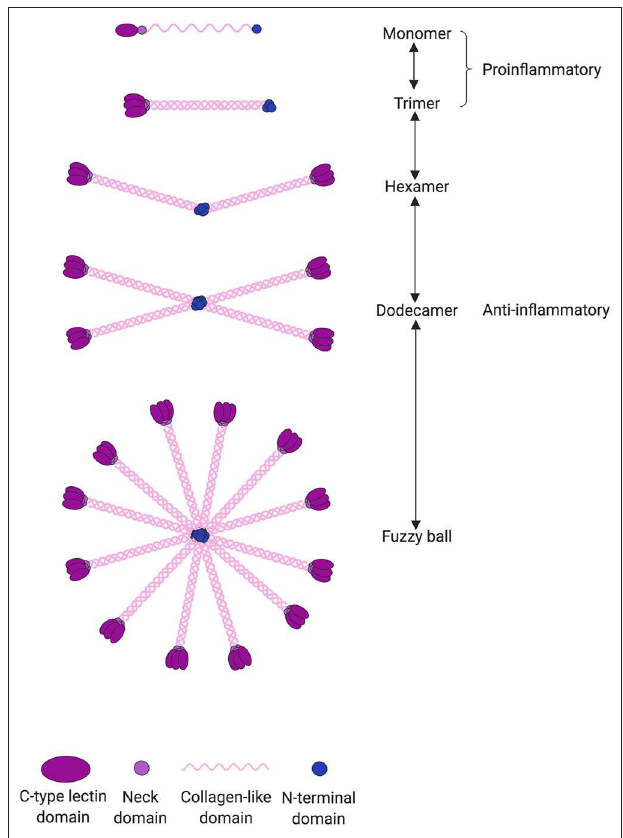
FIGURE 1 | SP-D can undergo several post-translational modifications leading to changes in both structure and function. SP-D is capable of multimerization depending on the local environment. The most common isoform is the dodecameric structure, which is thought to have anti-inflammatory properties through binding via its C-type lectin domain. However, in an inflammatory or more acidic environment, the dodecameric form can change to a trimeric or monomeric isoform. The monomers and trimers are believed to have pro-inflammatory properties through binding via its collagen-like domain. When pathogens are present, the C-type lectin domain is occupied by its corresponding ligand and thus incapable of eliciting its anti-inflammatory